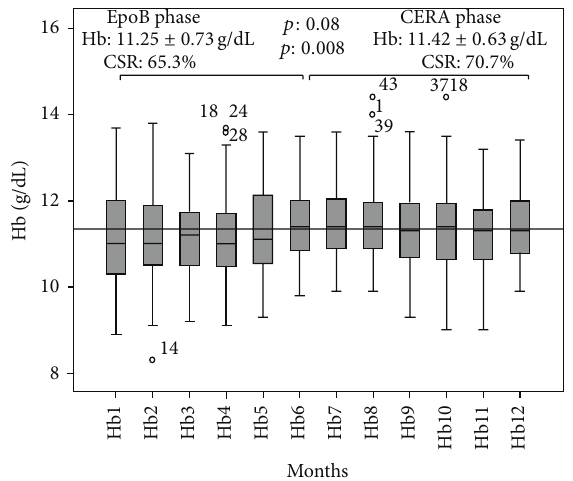
Figure 2: Evolution of mean Hb concentration during the two phases of the study. Hb: hemoglobin, EpoB recombinant human erythropoietin beta, CERA: continuous erythropoietin receptor activator, and CSR: clinical success rate (HB within the target 10,5–